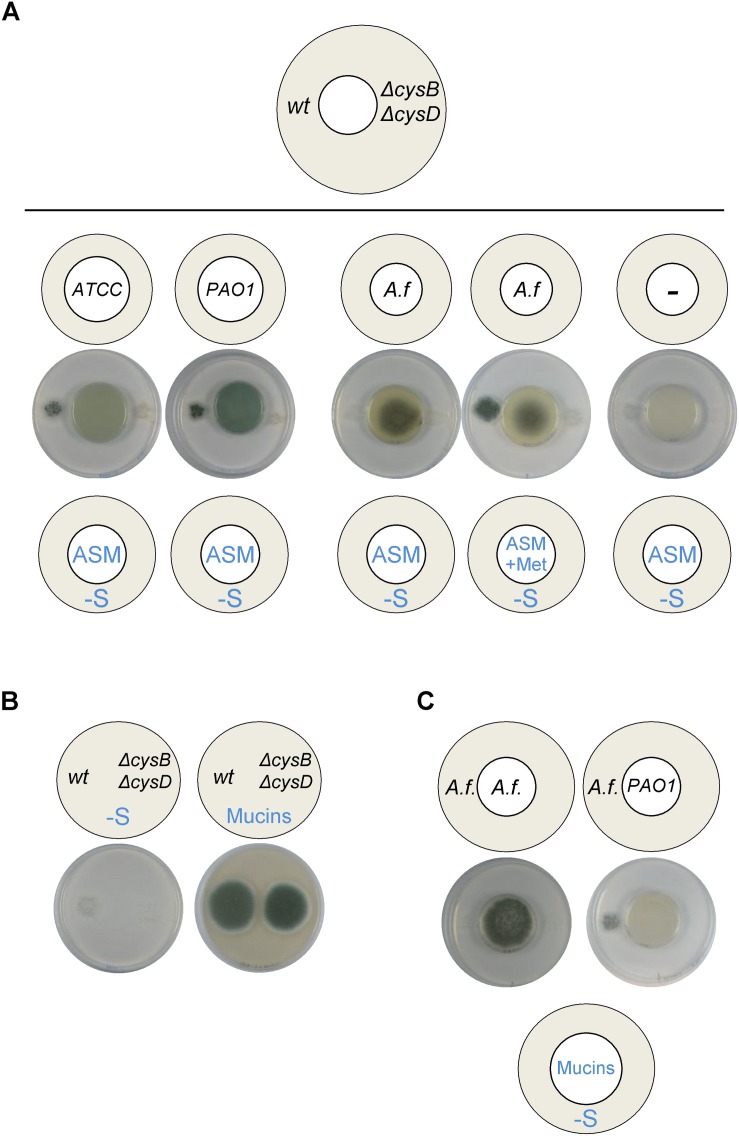
Pseudomonas aeruginosa produces VSCs from artificial sputum medium (ASM) and from mucins. (A) Growth of P. aeruginosa ATCC 9027 and PAO1 strains on ASM triggered distal A. fumigatus (A. f) growth. A. fumigatus needed supplementation of methionine to the ASM medium to trigger distal growth (i.e., to produce VSCs). (B)
A. fumigatus wild-type and ΔcysBΔcysD strains could exploit mucins as the sole sulfur source. (C) When grown on mucins as the sole S-source wild-type P. aeruginosa, but not A. fumgiatus, produced VSCs, which triggered distal A. fumigatus growth. Plates were incubated at 37°C for 3 days.